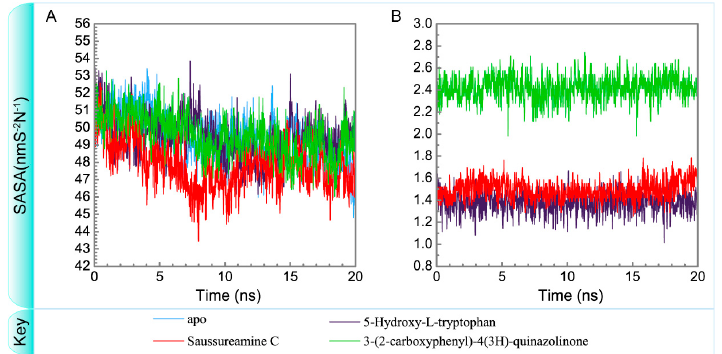
Figure 16. Variation of total solvent accessible surface area of ( A ) protein and ( B ) ligand over 20 ns for paraplegin in apo form and in complexes with three TCM candidates.